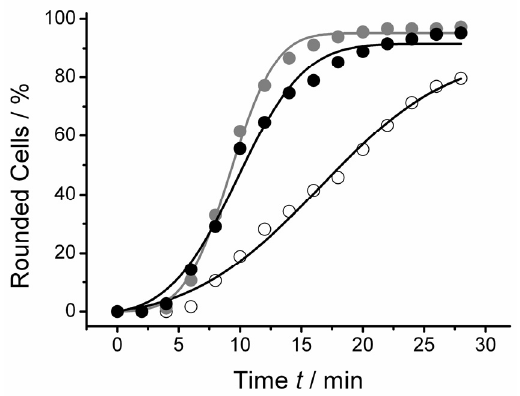
Figure 1. The graph shows cell rounding kinetics of L929 mouse fibroblasts on thermoresponsive substrates at 22 °C (black circles), 15 °C (gray circles), and 4 °C (open circles). The slow kinetics of cell rounding at 4 °C is indicative of an active cell